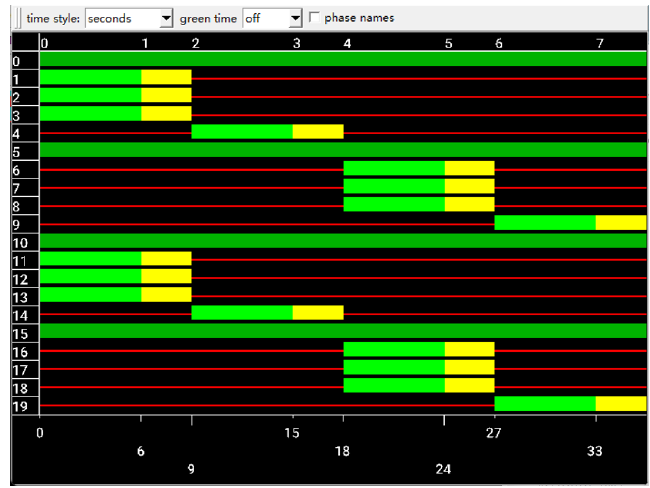
Figure 5. Phase selection.The diagram is derived from the interface of SUMO